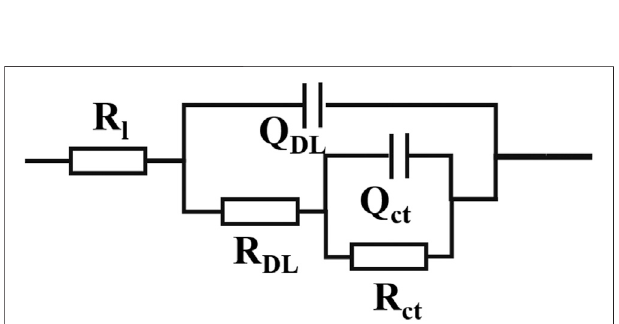
Figure 3 . After oxidation, the surface fi lm is fl at and locally